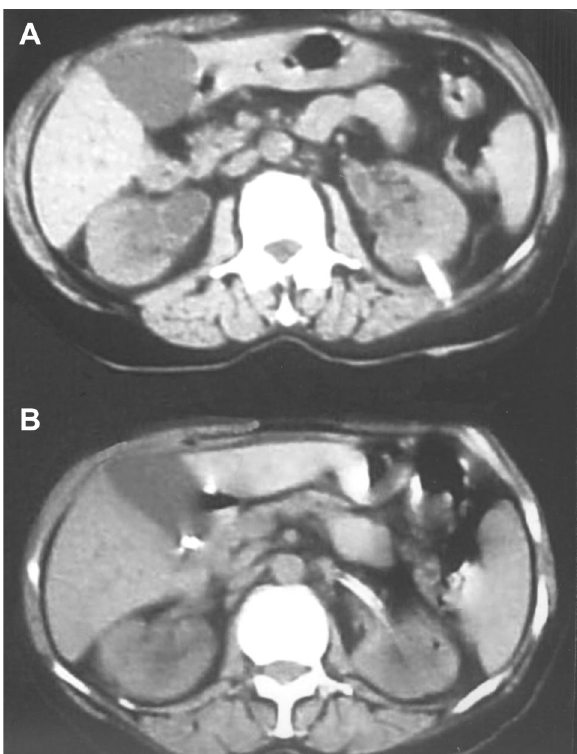
Figure 1 – A) Nephrostomy tube through renal parenchyma. B) Nephrostomy tube in left renal vein. A radiopaque gallbladder calculus can also be